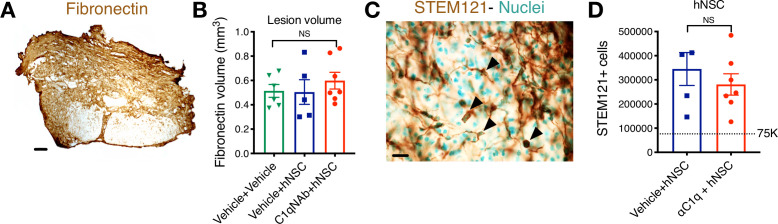
C1q epicenter blockade does not alter lesion volume or hNSC engraftment after transplantation.Histological analysis at 12 WPT. (A) Representative image of transverse spinal cord section immunostained for fibronectin at the SCI epicenter (brown; scale bar = 150 μm). (B) Quantification of host lesion volume by unbiased stereology using the Cavalieri probe in SCI mice that received vehicle + vehicle (green triangles), vehicle + hNSC (blue squares), or C1qNAb + hNSC (red circles). Mean ± SEM (N = 5–7). Comparisons between groups were conducted using one-way ANOVA (NS, p=0.6073). (C) Immunohistochemistry for the human-specific cytoplasmic marker STEM121 (brown; scale bar = 25 μm). Sections were counterstained for nuclei using methyl green; arrowheads indicate SC121+ cells with methyl green+ nuclei as quantified. (D) Quantification of the total number of hNSC by unbiased stereology using the optical fractionator probe in mice that received vehicle + hNSC (blue squares) vs. C1qNAb (red circles). Comparisons between groups were conducted using Student’s t-test (NS, p=0.4276).